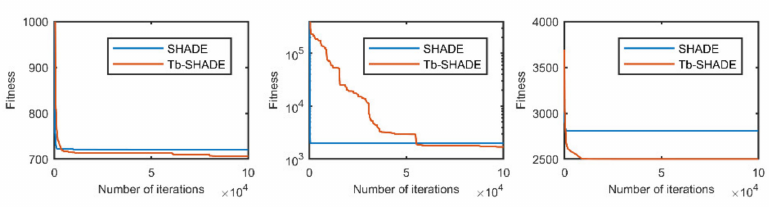
Figure 4. The selected average convergence of SHADE and Tb-SHADE is compared on CEC2020 in 20 D . From left to right f3, f5 and f9.